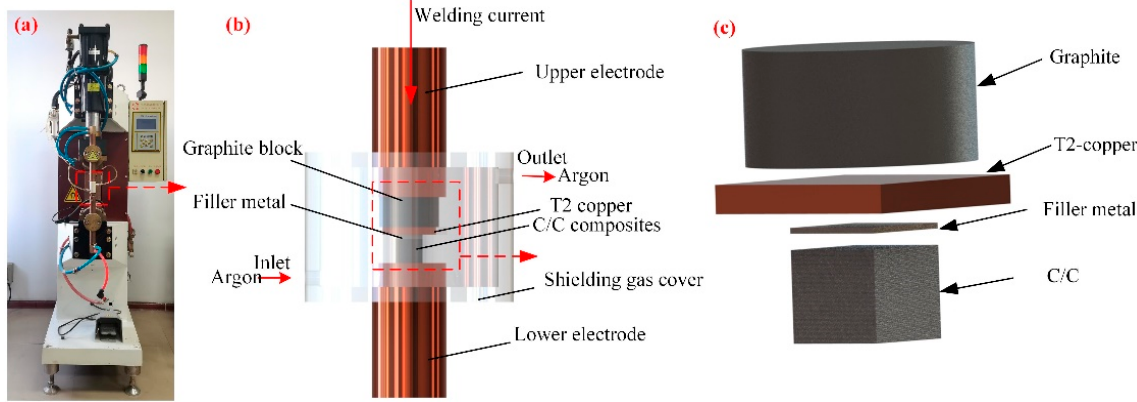
Figure 3. ( a )The actual image of the RBW welding process, Schematic diagram of ( b ) the welding process, and ( c ) the welding specimens.